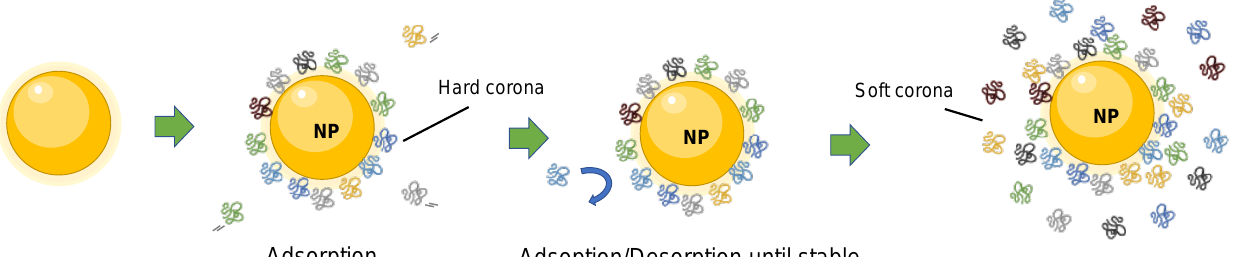
Figure 1. Scheme representation of the dynamic formation of nanoparticle–protein corona complex. Proteins in the inner layer have high affinity for the nanoparticle surface and form the hard corona. The proteins in the outer layer form the soft corona, which shows dynamic changes due to exchanges with free proteins in the environment.